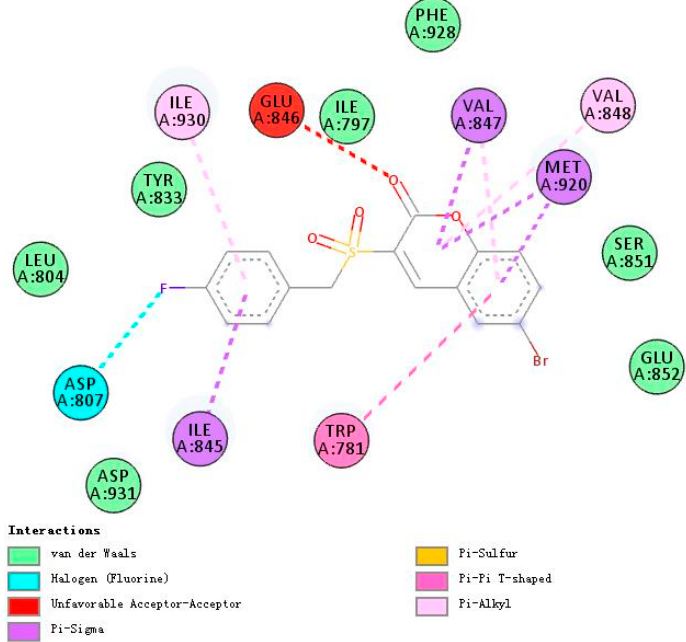
Figure 9. A 2D model of the interaction between compound 5m with the active site of PI3K β .